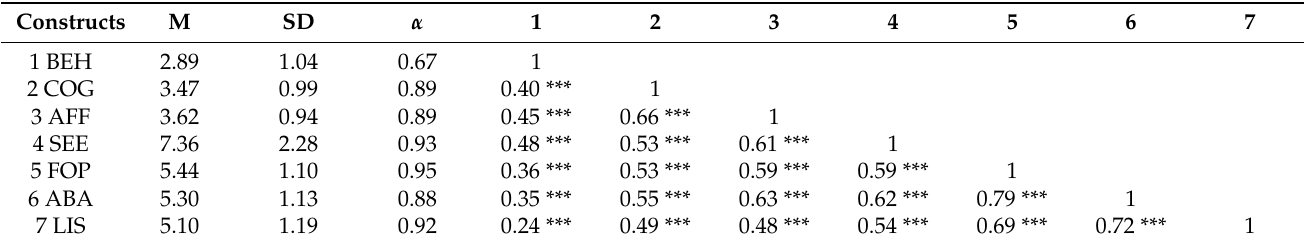
Table 2. Descriptive statistics, correlation analysis, and reliability